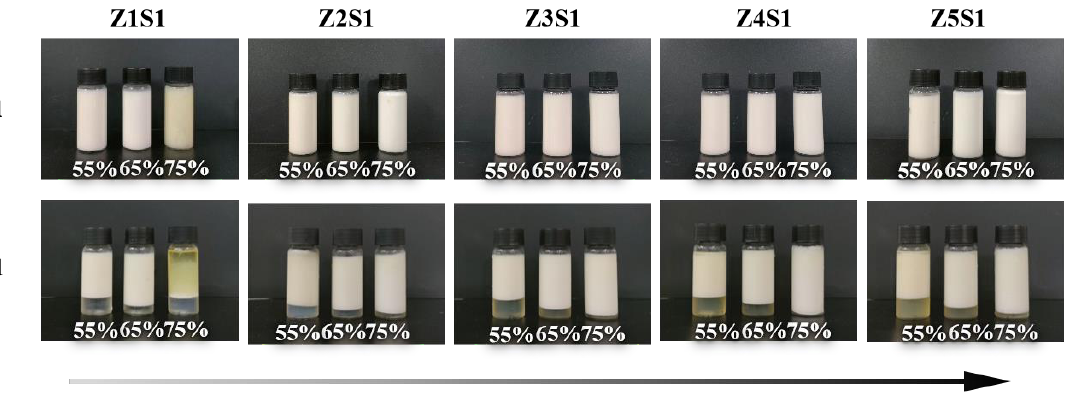
Figure 7. The visual appearance of Pickering emulsions stabilized by ZS particles with different oil part fractions at 0 d and 60 d.